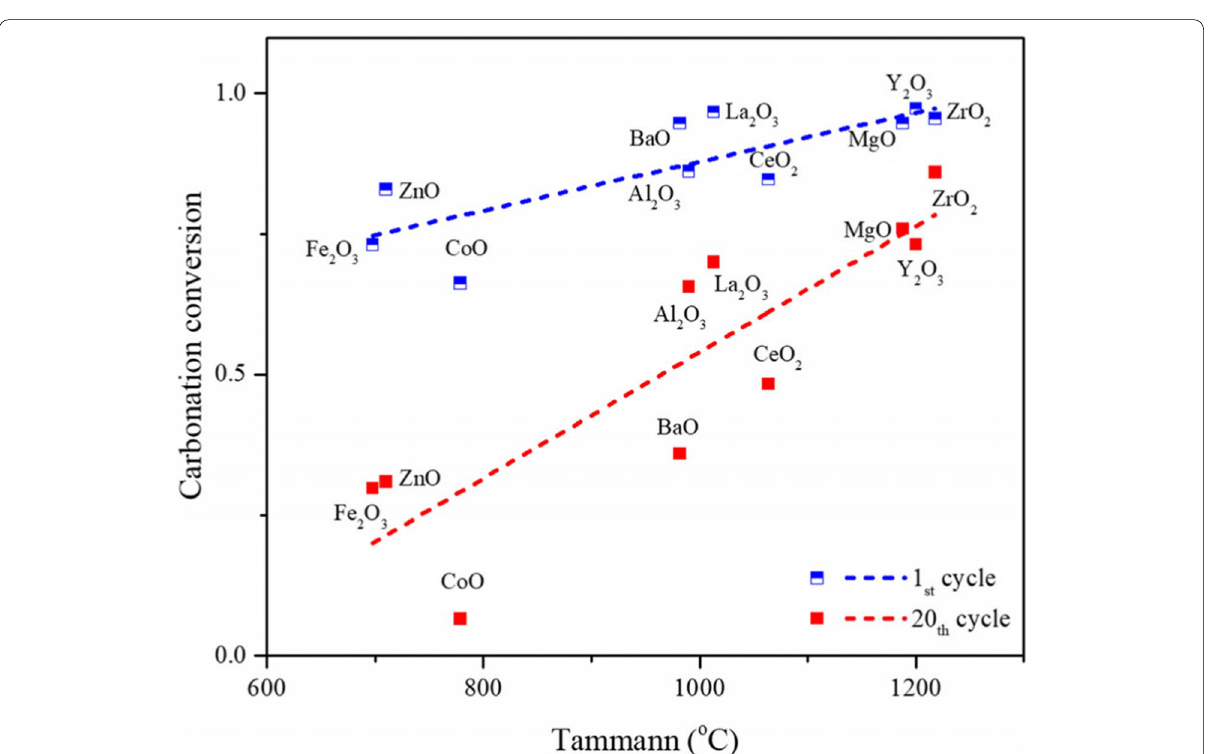
Fig. 13 Carbonation conversion of the different doped CaO during the first and 20th cycle as a function of the Tammann temperatures of the dopants [63,